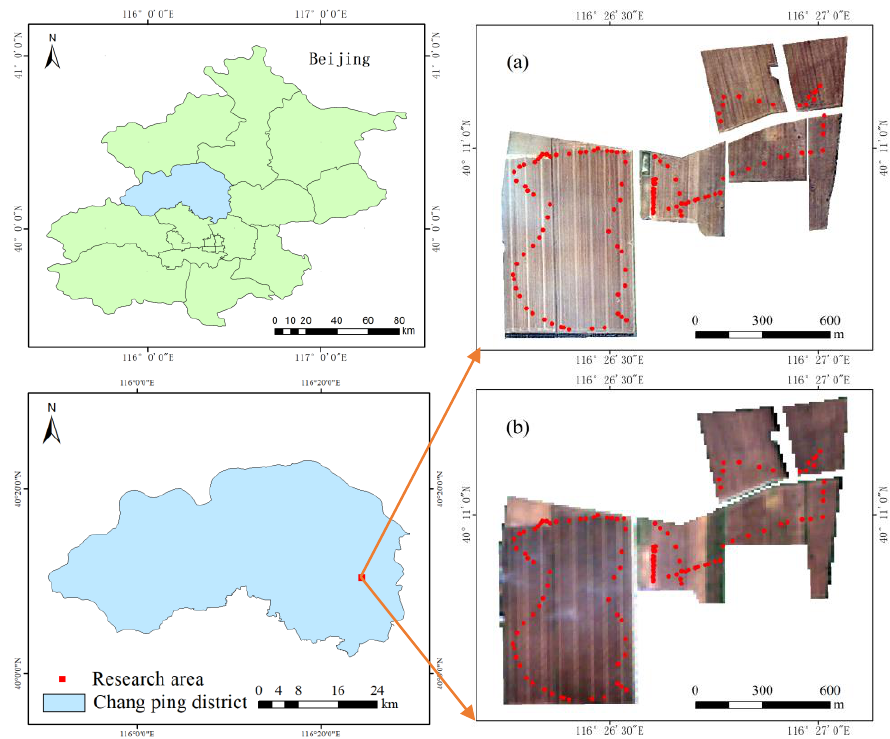
Figure 1. Location of study area and remote sensing imagery (( a ) GF-1; ( b ) Sentinel-2).